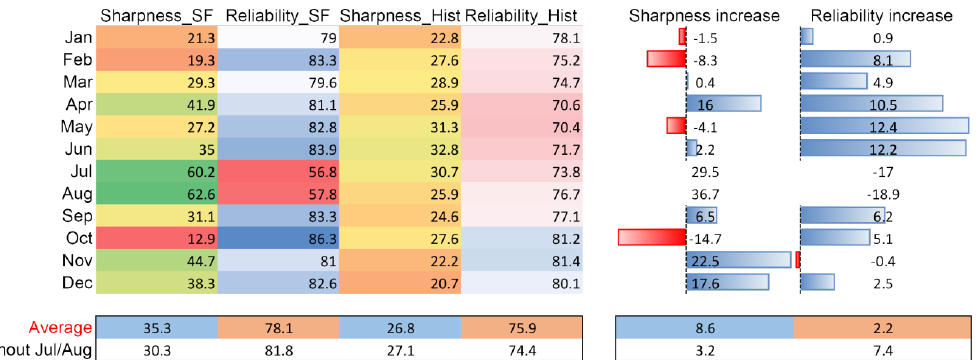
Figure 8. Average values for the reliability and sharpness for each month throughout the different lead times according to the Seasonal Forecast (SF) and the traditional method (Hist) ( left ), and the change of CS prediction reliability and sharpness with respect to traditional prediction reliability and sharpness ( right ), for the study period 1981–2015.